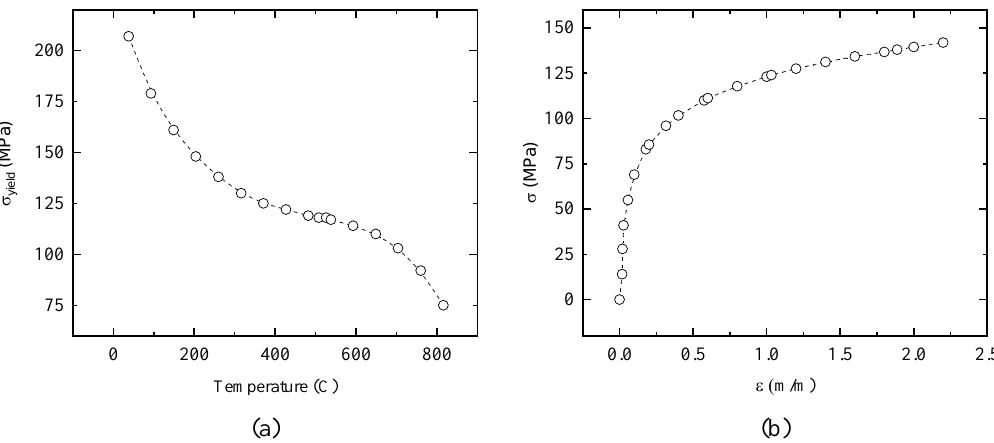
Figure 10. ( a ) Yield stress function of the temperature and ( b ) the isochronous stress–strain curve.